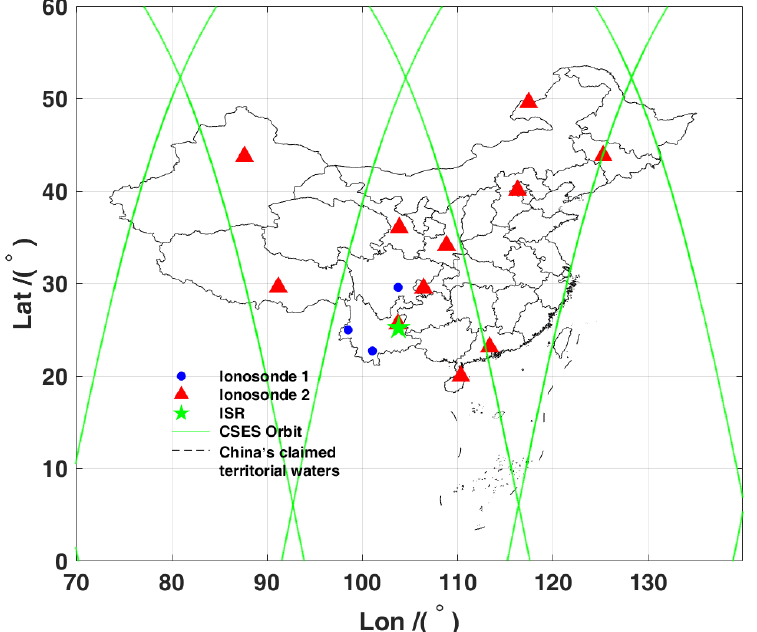
Figure 1. Locations of ground-based observation stations in China. Blue points represent ionosonde stations of IEF with continuous-time data. Red triangles indicate ionosonde stations of CRIRP at different latitudes. Green star means the location of the ISR station. Green lines are the footprints of the CSES in one day.